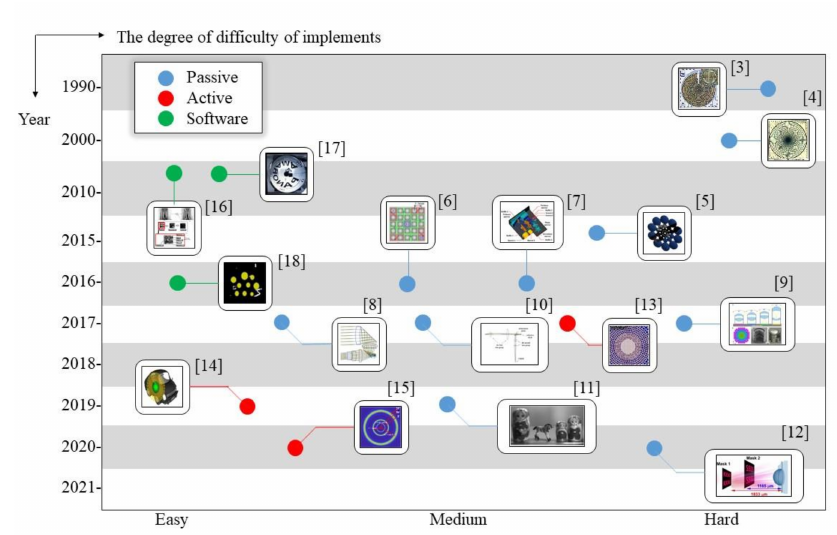
Figure 3. Implementation methods of retina-like